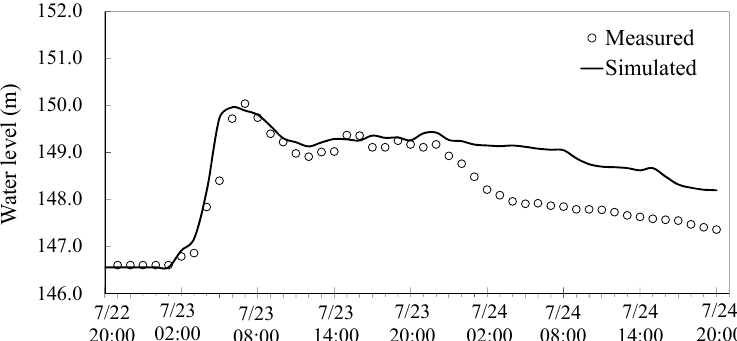
Figure 13. Comparison of the measured water level and the simulated result at Mingchu gauging station during Typhoon Matmo (July, 2014).